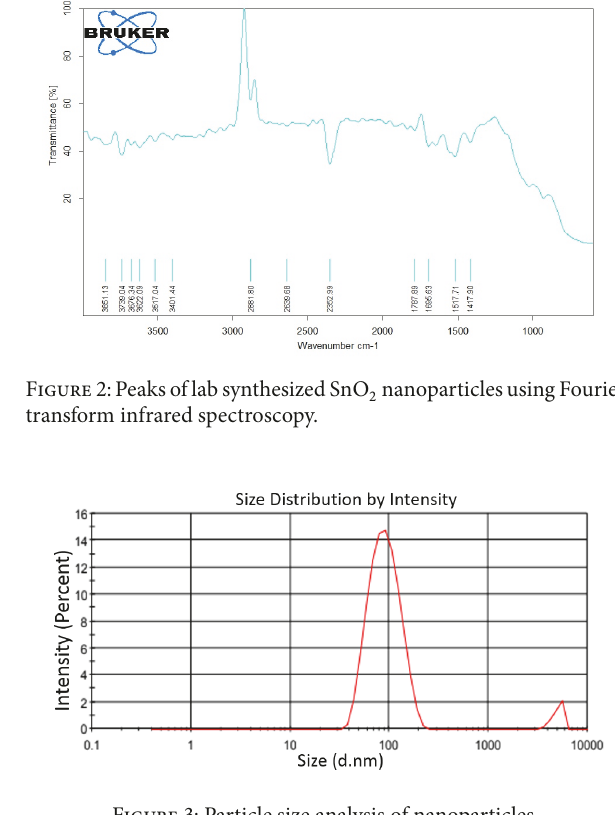
Figure 3: Particle size analysis of